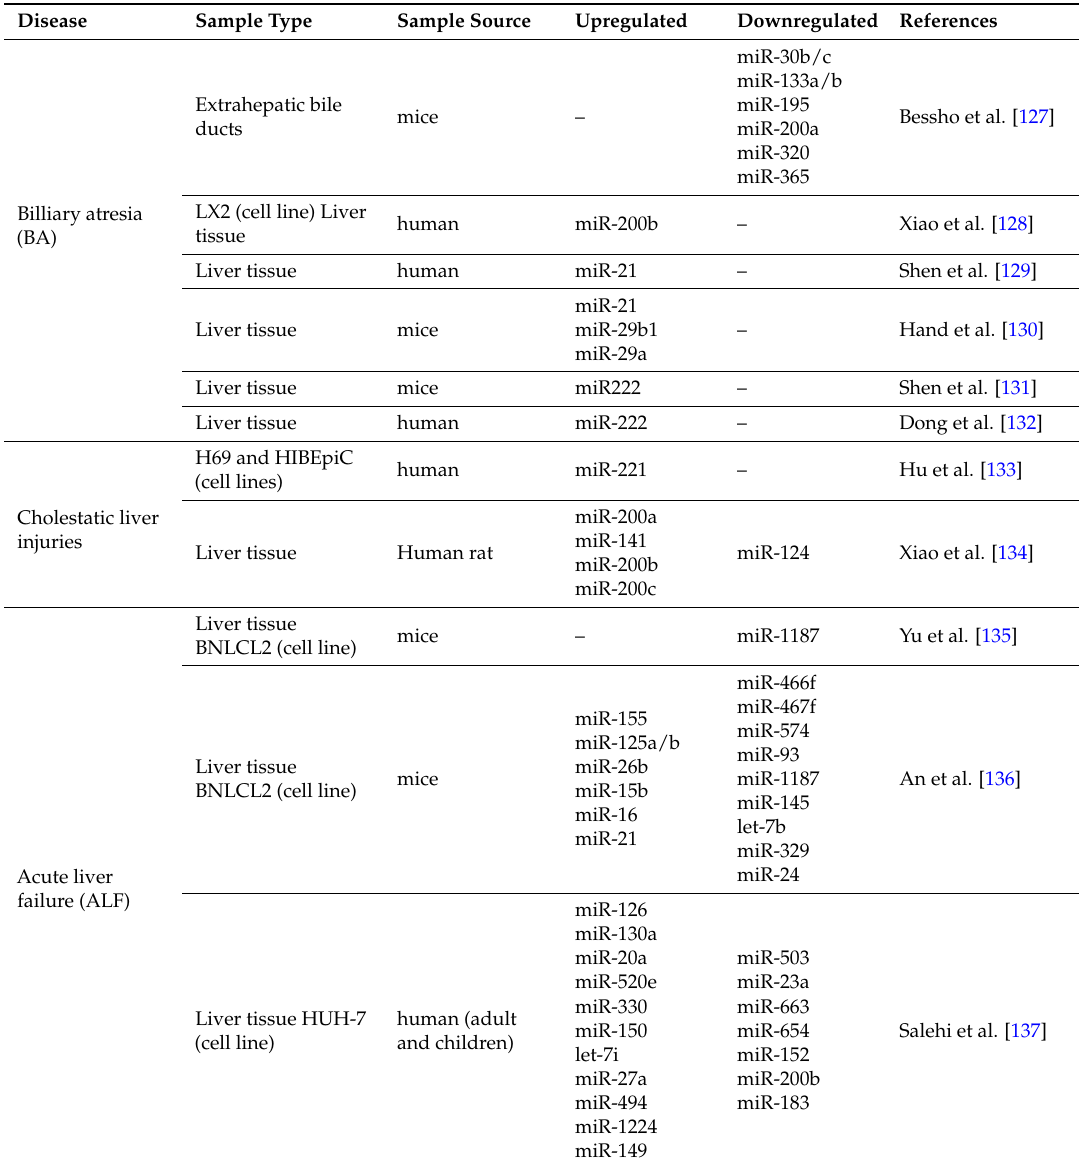
Table 2. Functional miRNA studies in paediatric liver